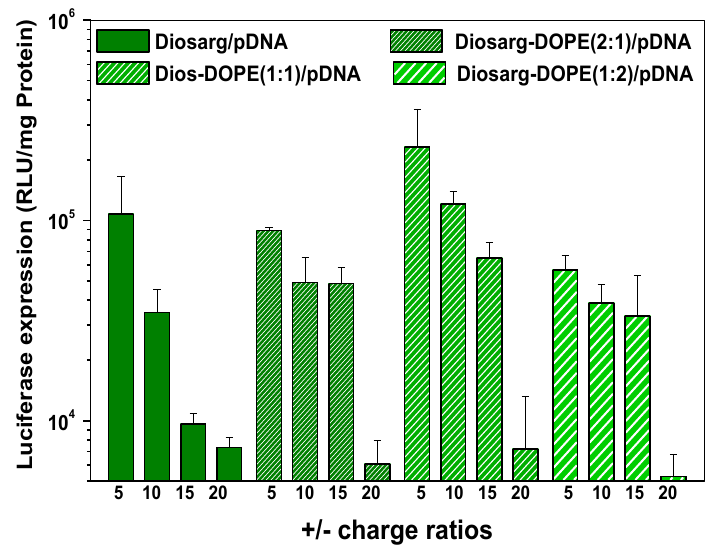
Figure 7. In vitro luciferase gene transfection efficiencies of the Diosarg lipid and Diosarg-DOPE (2:1, 1:1, 1:2) NPs/pDNA complexes at various +/− charge ratios in H1299 cells.